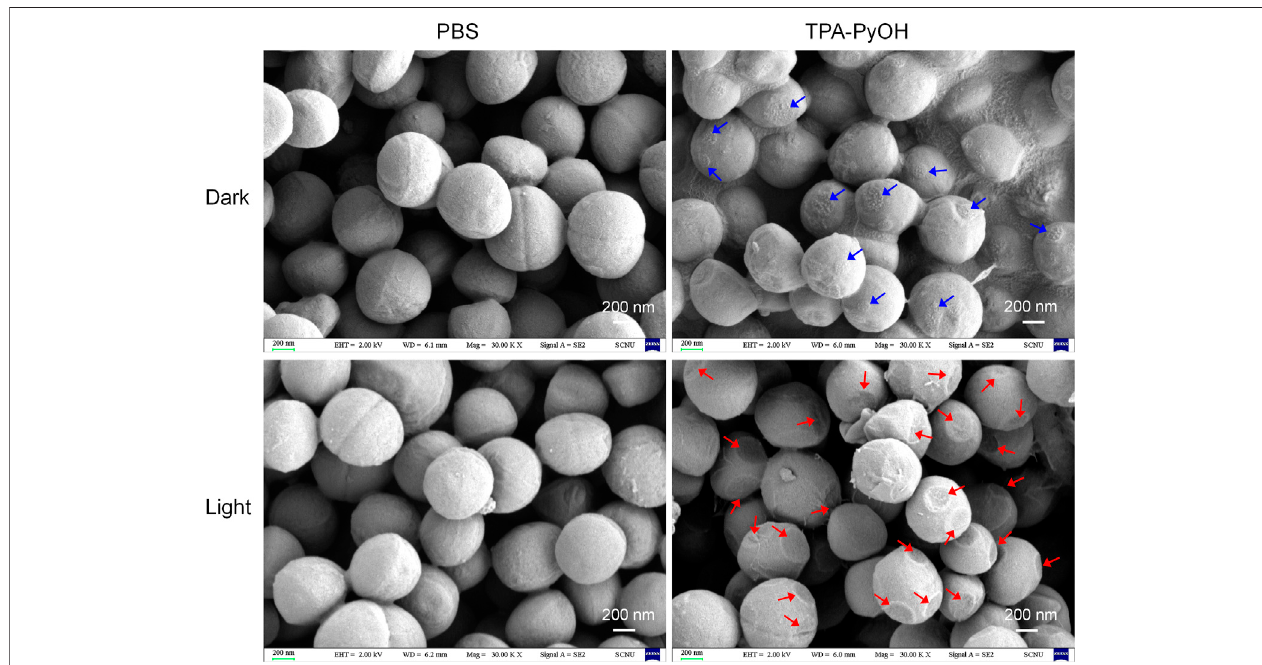
FIGURE6 | SEM images of S. aureus upon diversetreatments.The blue arrows indicated probable adhesion sites ofTPA-PyOH withthe bacteria. The red arrows indicated the obvious damage sites on the membrane upon photodynamic treatments.